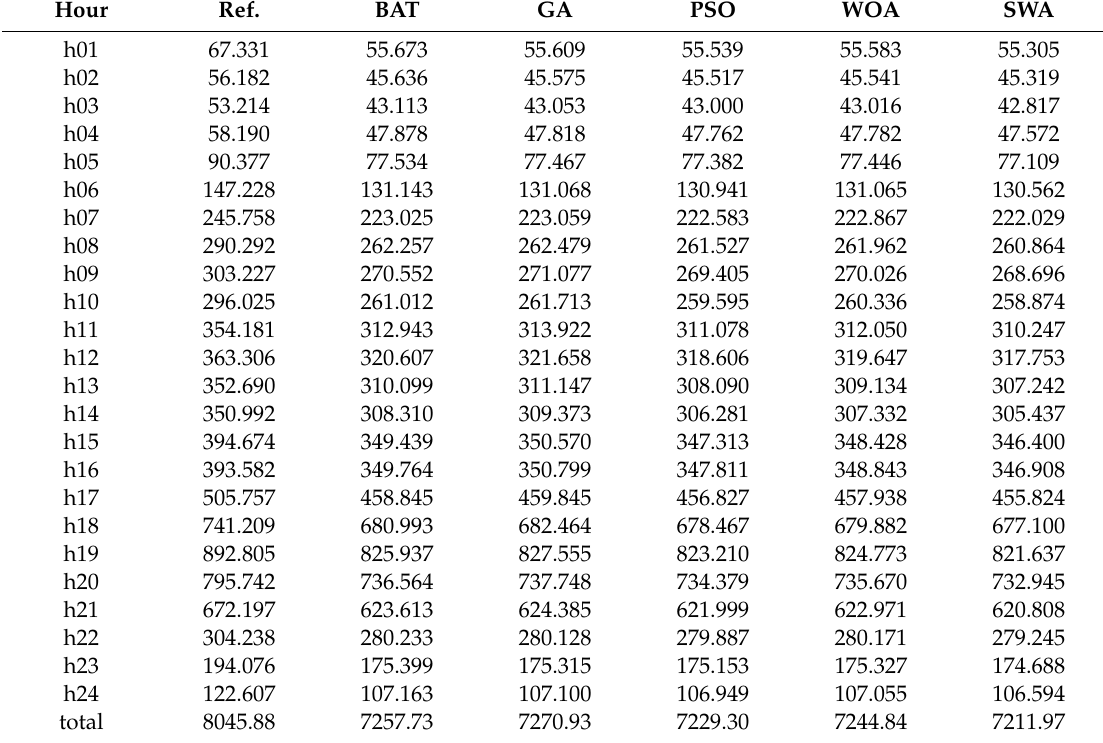
Figure 23. The fitness of the optimal solution found by the metaheuristic algorithms after 360 iterations, for the 215-bus network. Table 13. Hourly and total active power losses in the 215-bus network, in kW, for each